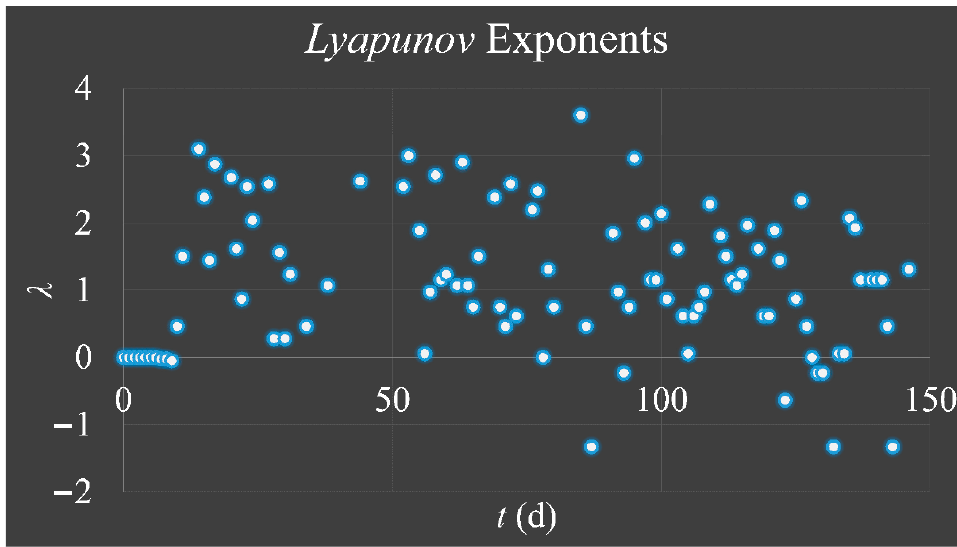
Figure 10 . Calculations of the Lyapunov exponent ( λ ) for initial population 20 cells/ μ L and 200 cells/ μ L. We have calculated the Δ 0 as Δ 0 = | x 0 − x 0 ′ |, where x 0 = 20/max and x 0 ′ = 200/max. The maximum population was considered to be the max population reached for each experiment in cells/ μ L.